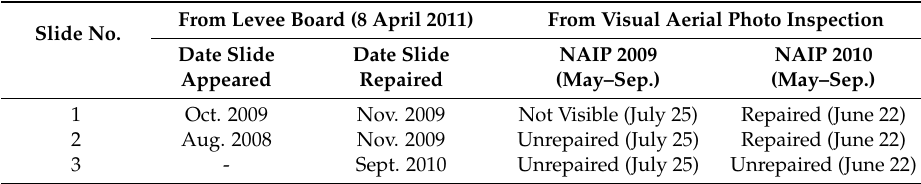
Table 2. Updated slides ground truth from the Mississippi Levee